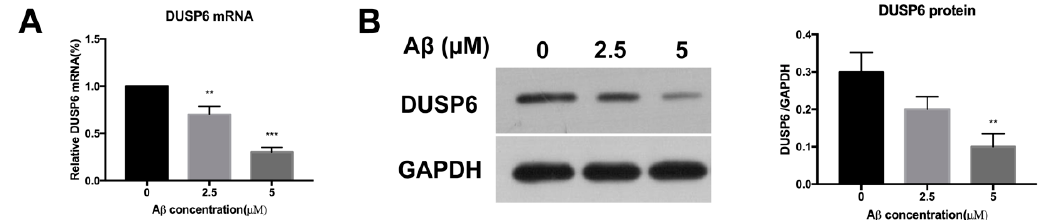
Figure 1. Beta amyloid (A β )25–35 treatment reduced dual specificity phosphatase 6